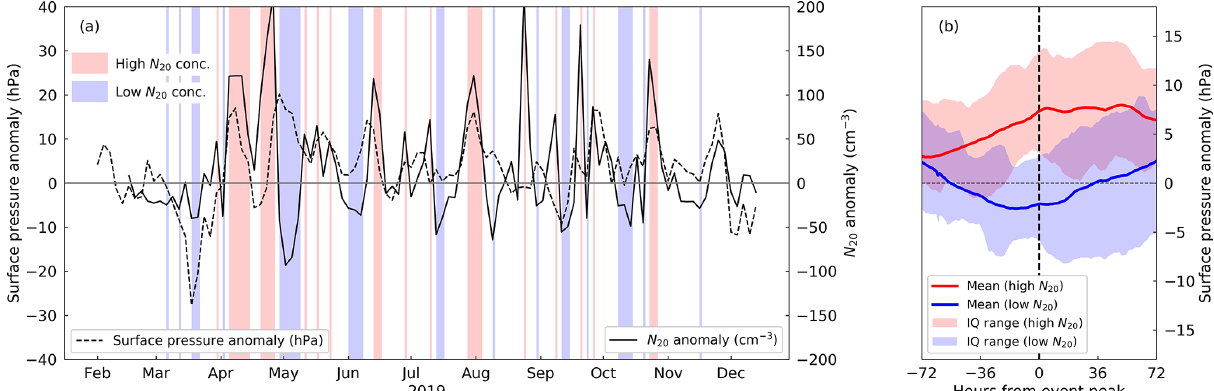
Figure 7. (a) Surface pressure anomaly (3d mean, solid black line) and N 20 anomaly (3d median, dashed) during 2019. Red and blue shading highlight high- and low-aerosol-concentration events, respectively (high/low events are where the N 20 anomaly is above the 75th/below the 25th percentile). (b) The mean and interquartile range in surface pressure anomaly across all high (red) and low (blue) N 20 events, for the 72h before and after the maximum (minimum) N 20 for each high (low)